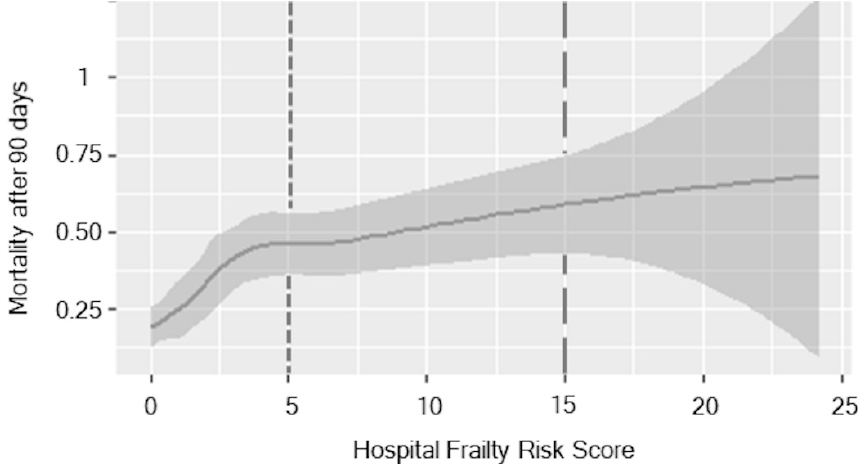
Figure 1. Association of HFRS over mortality after 90 days. The different HFRS risk categories are divided by the grey lines. The first line is the boundary between the low- and moderate-frailty risk category, the second line between moderate- and high-frailty risk. The grey shade is indicating the standard deviation.